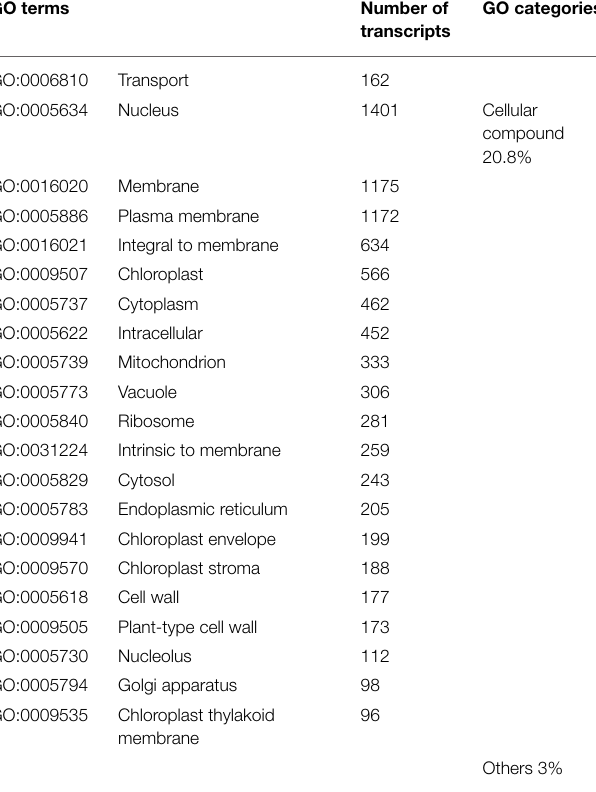
Figure 3 illustrates the distribution of four protein functions (resistance/defense, flower color, flowering, and cold tolerance) and the number of rose candidate genes identified within